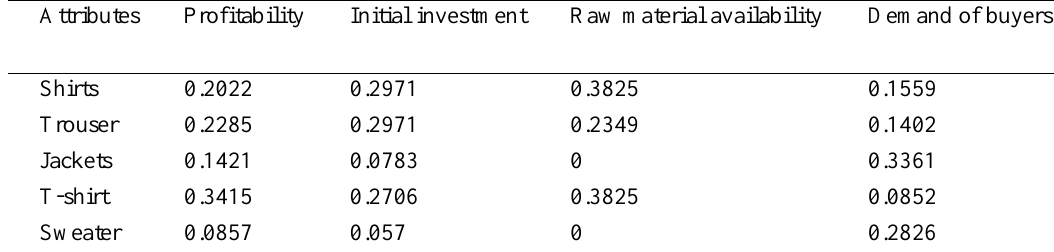
Table 10. Weights of each alternative to each criterion.